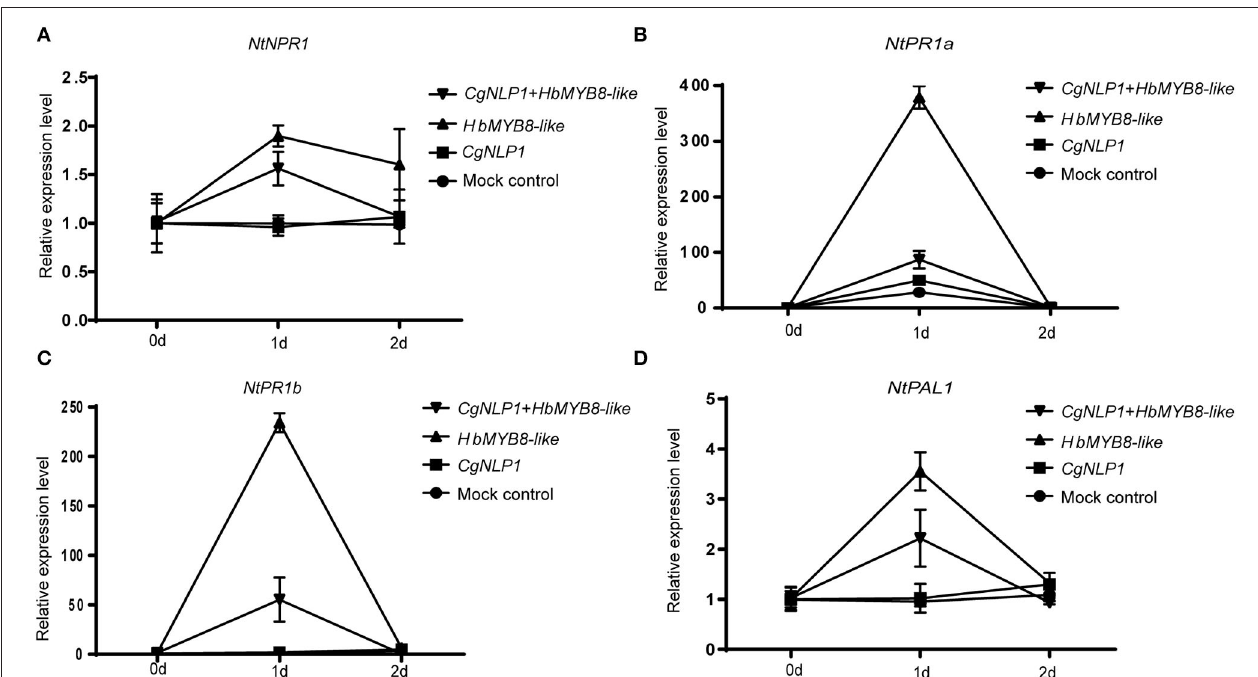
FIGURE 9 | (A–D) Expression patterns of genes related to the salicylic acid (SA) signaling pathway in the tobacco leaves expressing HbMYB8-like and co-expressing HbMYB8-like and CgNLP1. Data are shown as the means ± SD from three independent